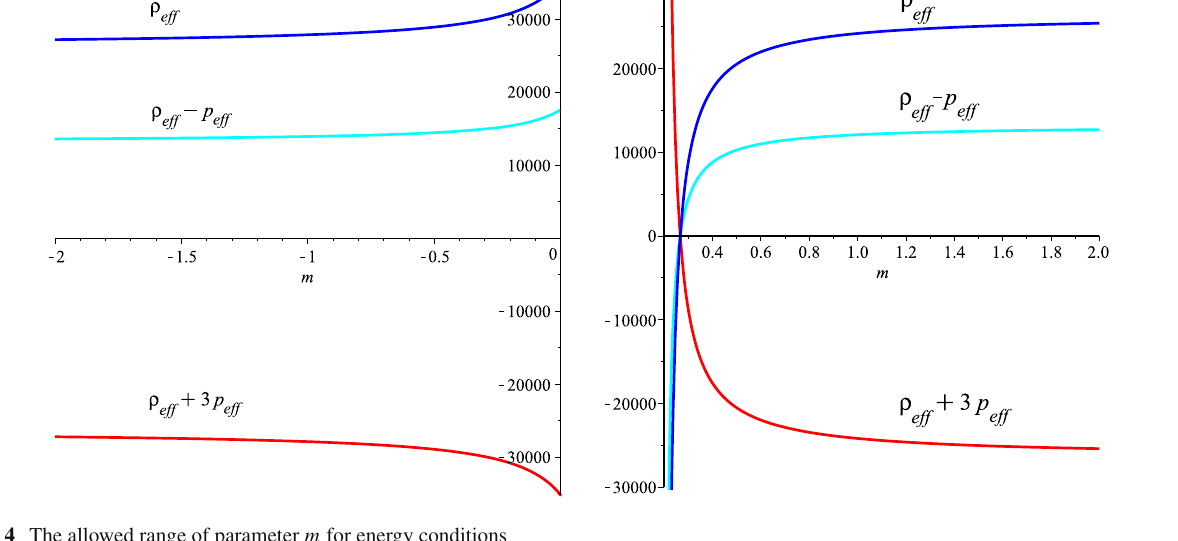
Fig. 4 The allowed range of parameter m for energy conditions